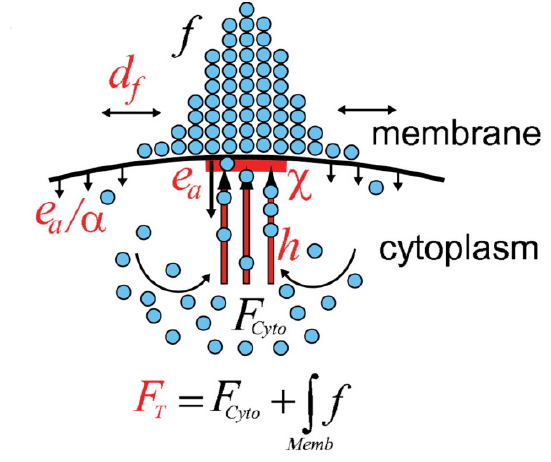
Figure 17. Schematic diagram of the model. From Marco et al.